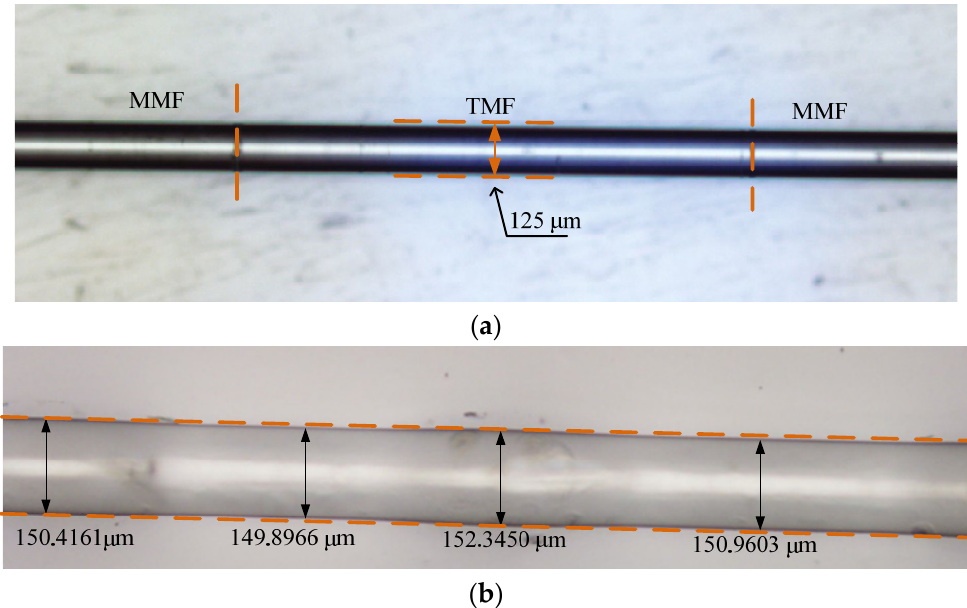
Figure 1. Microscopic images of sensors: ( a ) original fiber sensor. ( b ) PDMS-coated fiber sensor [20].